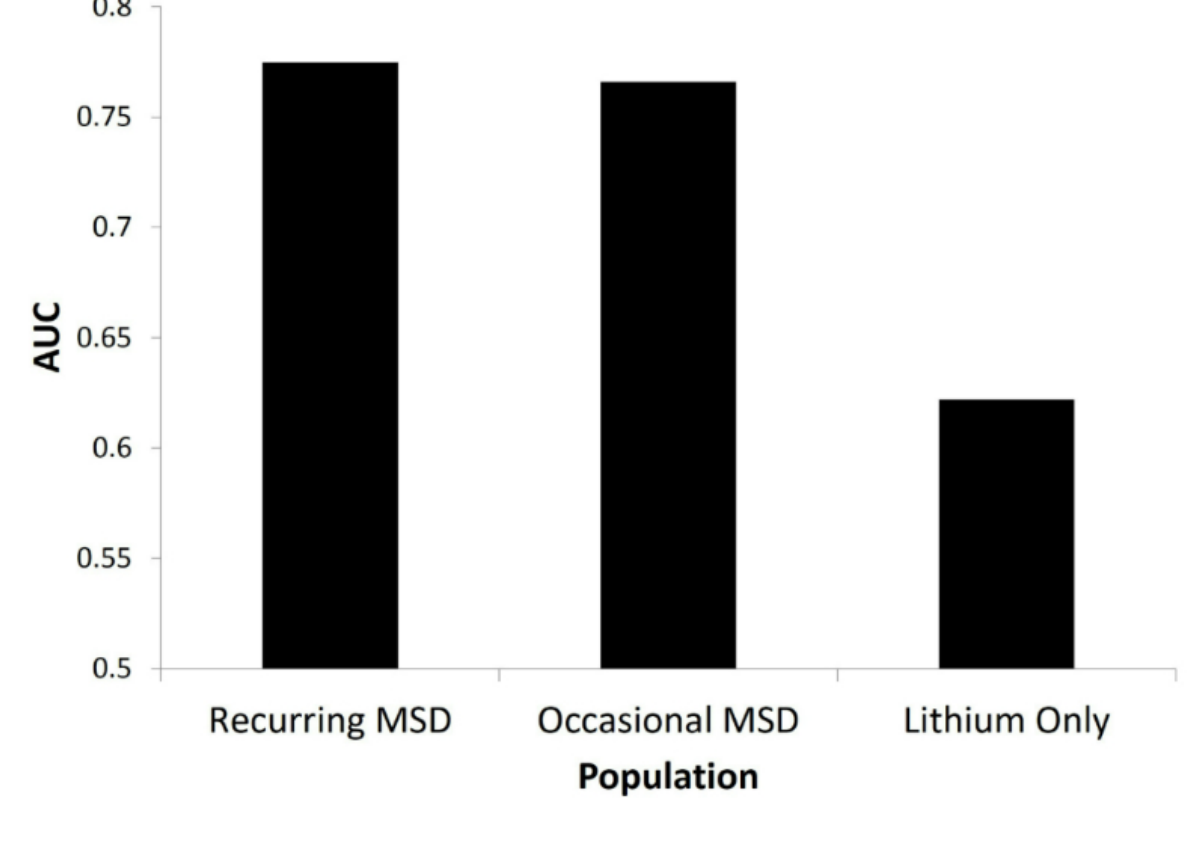
Table 3. Attributes of classifier for predicting days when mood stabilizing drug (MSD) queries are posted. a